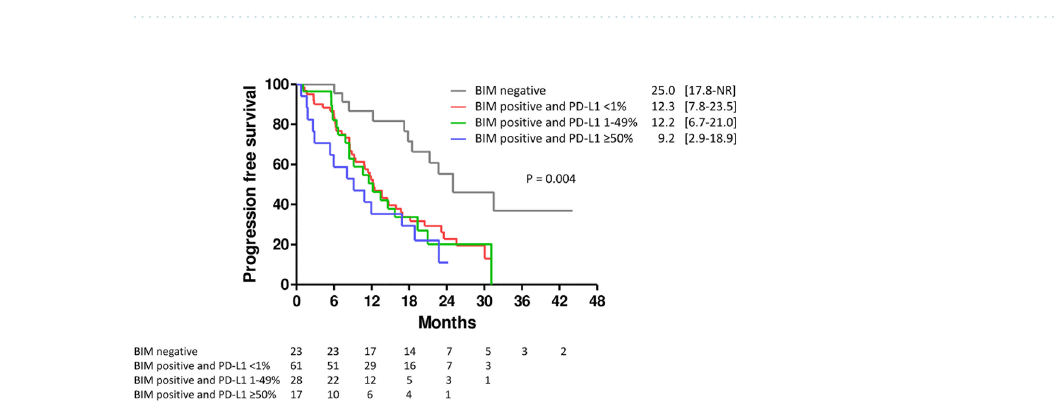
Table 2. Cox proportional hazards regression analysis of progression-free survival. EGFR, epidermal growth factor receptor.